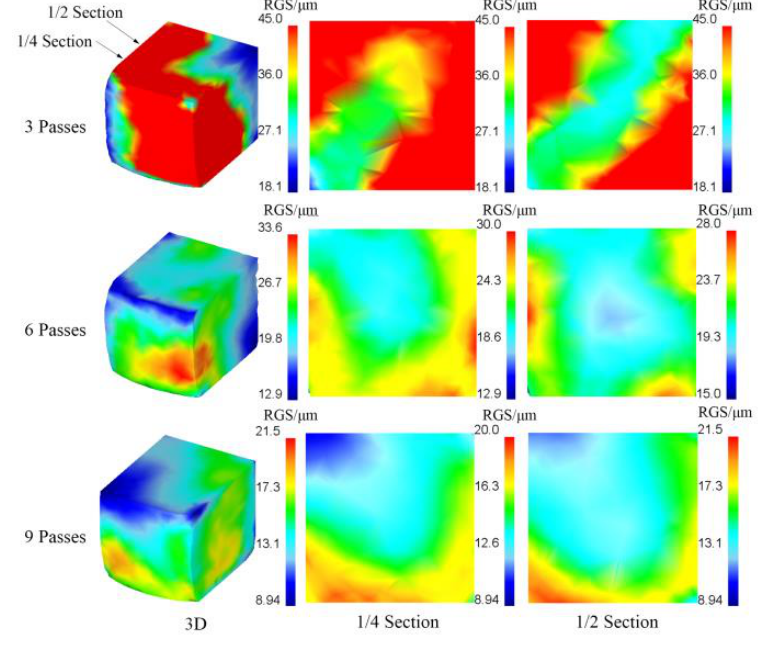
Figure 5. Different cloud size distribution cloud maps for single-open MDF at 800 °C.